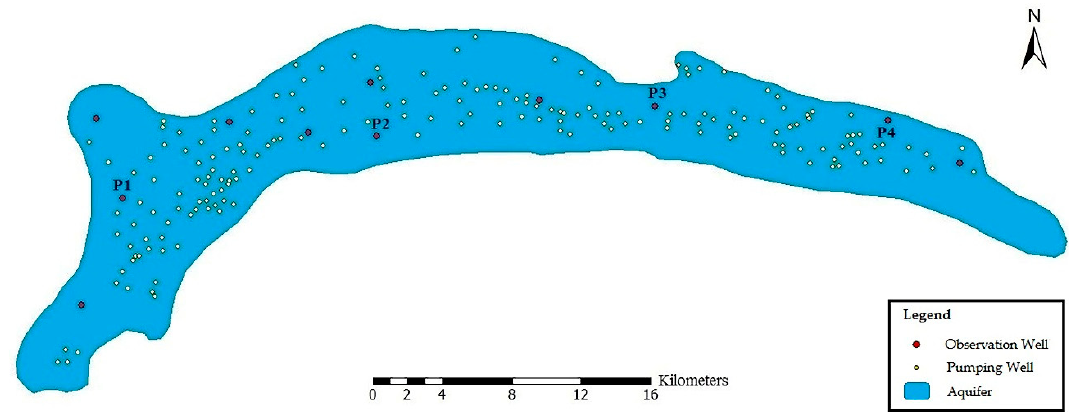
Figure 9. Location of pumping and observation wells (piezometers) in Birjand aquifer. P1, P2, P3, and